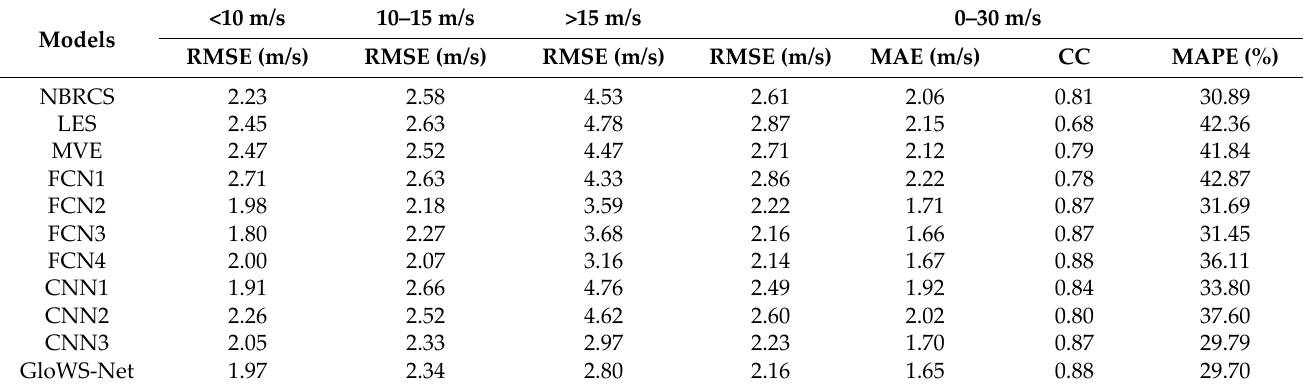
Table 6. Accuracy of wind speed retrieved from different models using CCMP data as